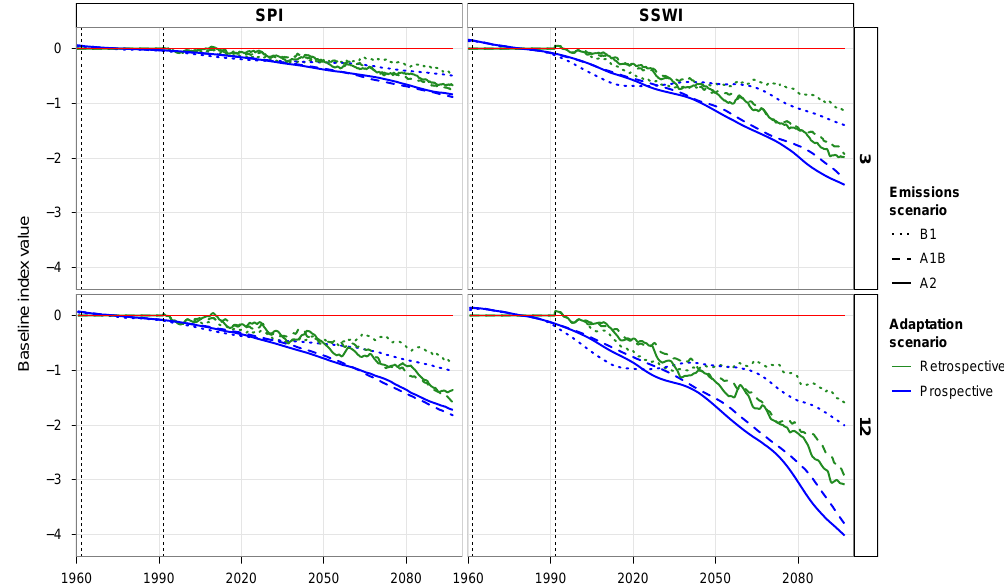
Fig. 2. Evolution of drought index baseline averaged over France, according to each adaptation scenario described in Table 3. Columns show the 2 different indices and rows show the 2 different time scales. The reference period is framed by dashed vertical lines.